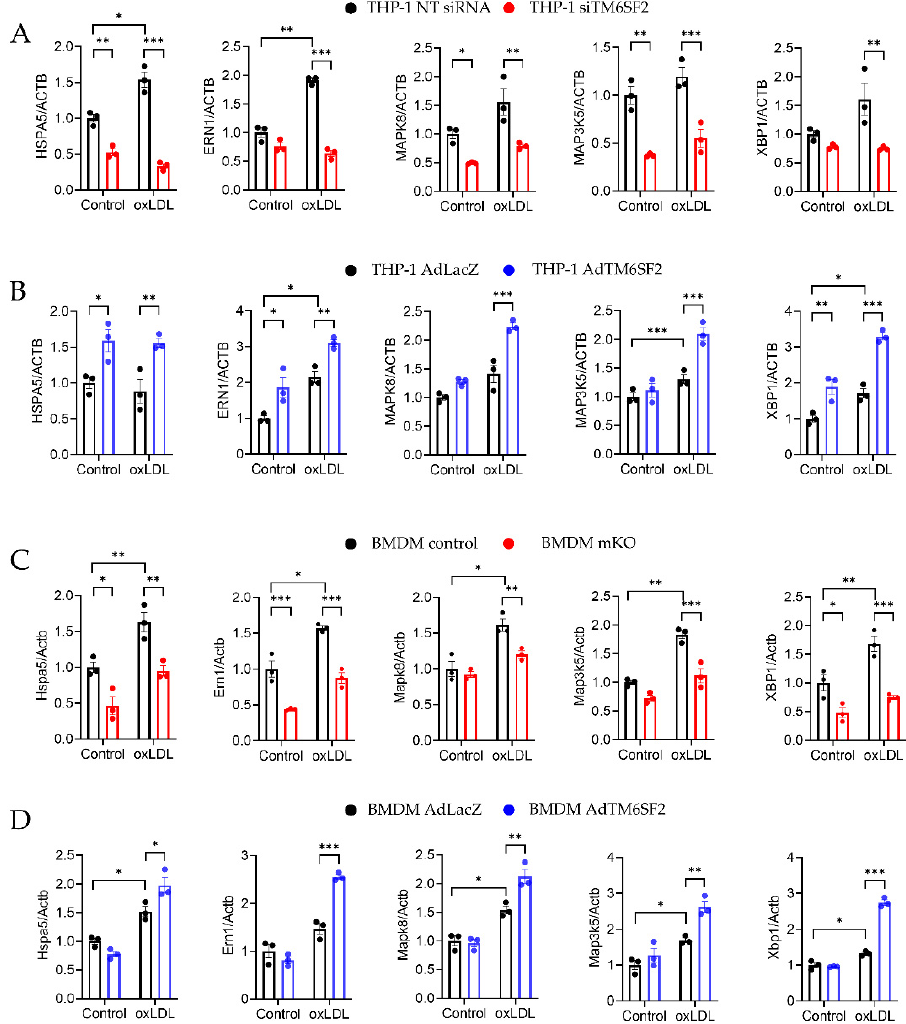
Figure 5. TM6SF2 Regulates ER stress-related Gene Expression in Macrophages. Macrophages were loaded with 100 µg/mL oxLDL overnight at 37 °C and mRNA expression of BIP , IRE1 α , JNK , ASK1 and XBP1 were measured by qRT-PCR. ( A ) THP-1-derived macrophages were transfected with TM6SF2 siRNA or NT siRNA (20 nM) for 48 h and ( B ) THP-1-derived macrophages were infected with AdTM6SF2 or AdLacZ (100 MOI) for 48 h. ( C ) BMDMs were isolated from control and mKO mice and treated with oxLDL (100 µg/mL) overnight. ( D ) BMDMs were isolated from wild type C57BL/6J mice and were transfected with AdLacZ or AdTM6SF2 (100 MOI) for 48 h and treated with oxLDL (100 µg/mL) overnight. n = 3 for each group. All data are presented as mean ± SEM, statistics by 2way ANOVA. * p < 0.05, ** p < 0.01, *** p < 0.001 as indicated.